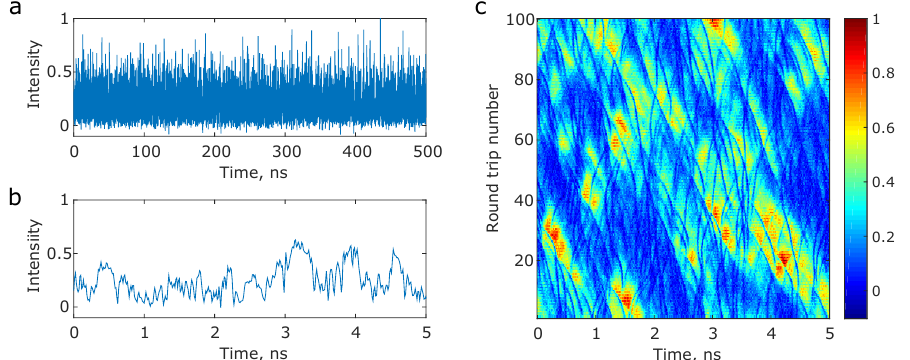
Figure 2. Spatio-temporal dynamics of Raman fibre lasers—Typical quasi-continuous wave intensity dynamics of a Raman fibre laser over ( a ) long and ( b ) short time scales; ( c ) The corresponding spatio-temporal dynamics. The color scale indicates normalized